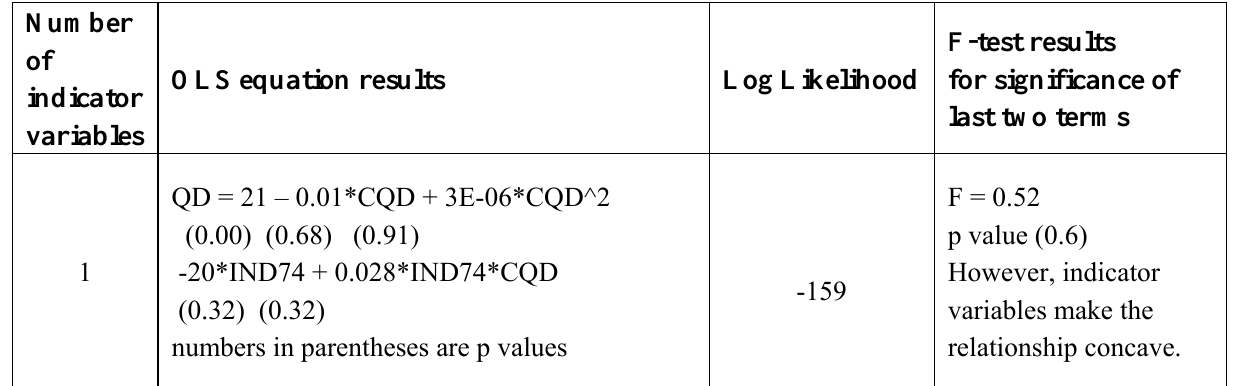
Table 2. Double Hubbert Cycle OLS results.